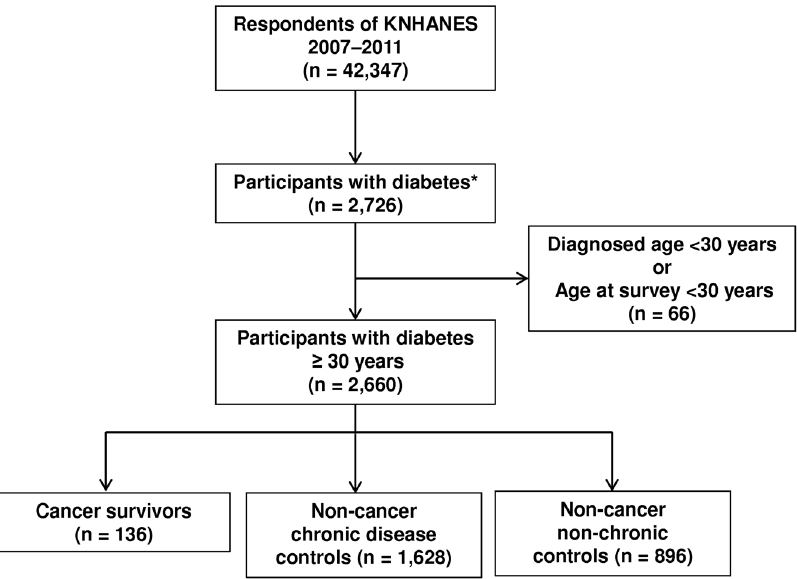
Figure 1. The process used to select the study population. KNHANES, Korea National Health and Nutrition Examination Survey. *Subjects with fasting plasma glucose levels of $ 126 mg/dL, or with a previous clinical diagnosis of diabetes made by a physician, or taking insulin or oral anti- diabetic medication.